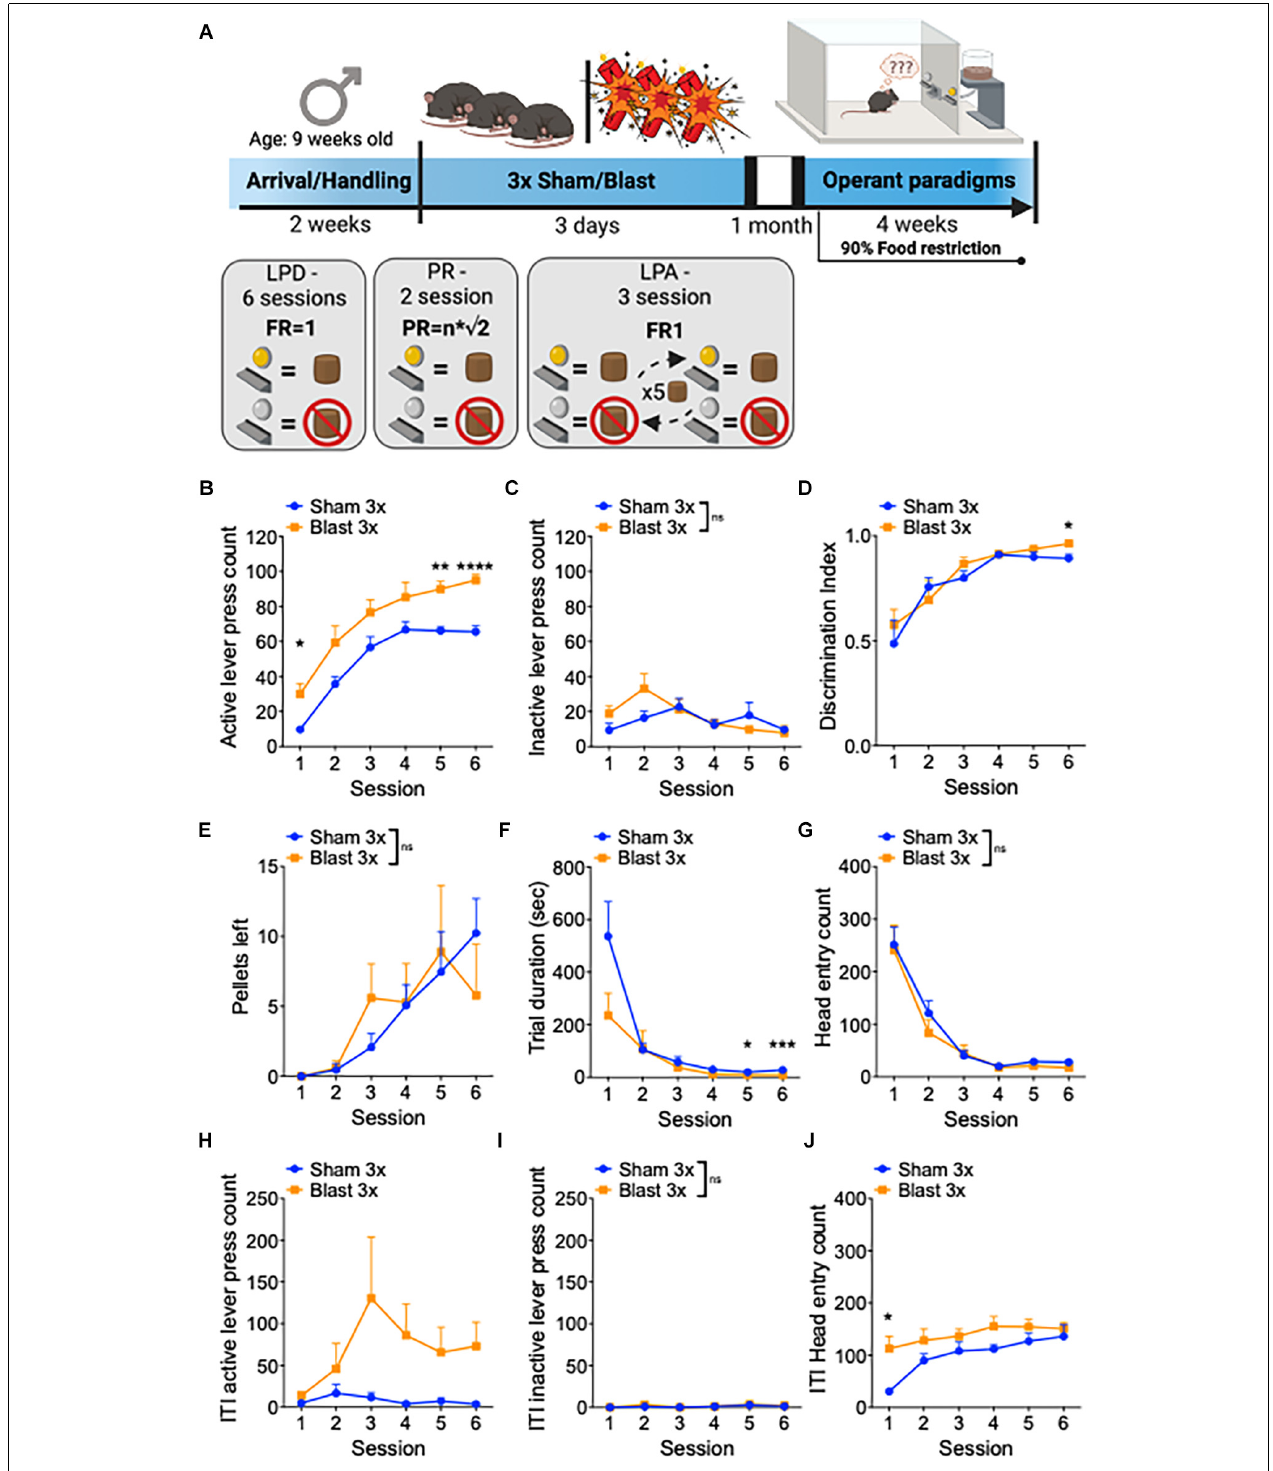
FIGURE 2 | Repetitive blast exposure increases appetitive operant behavior. (A) Timeline schematic. (B) Number of active lever presses. (C) Number of inactive lever presses. (D) Discrimination Index (active − inactive/active + inactive). (E) Number of pellets left uneaten. (F) Trial duration in seconds. (G) Number of head entries during lever out. (H) Number of active lever presses during ITI. (I) Number of inactive lever presses during ITI. (J) Number of head entries during ITI. Two-way RM ANOVA Bonferroni-Šídák post hoc (B–J) . * p ≤ 0.05, ** p ≤ 0.01, *** p ≤ 0.001, **** p ≤ 0.0001, ns, not significant. Values represent mean ± SEM. ITI,